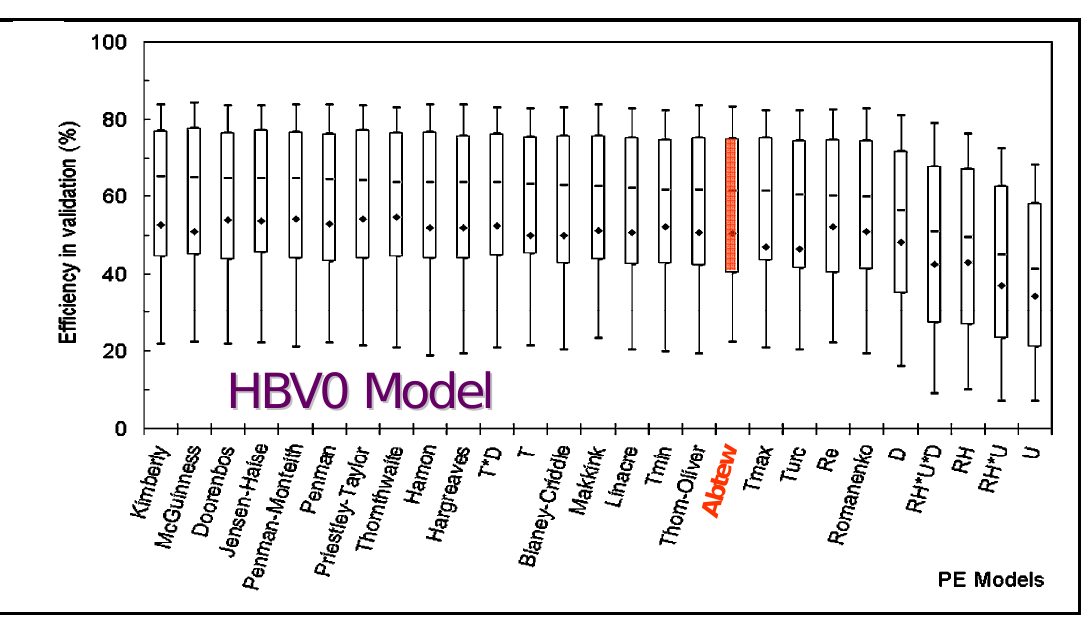
Figure 3. Average and 0.10, 0.25, 0.50, 0.75 and 0.90 percentile of Nash-Sutcliffee (E) Criteria obtained by 27 PE models in validation mode for HBVO model